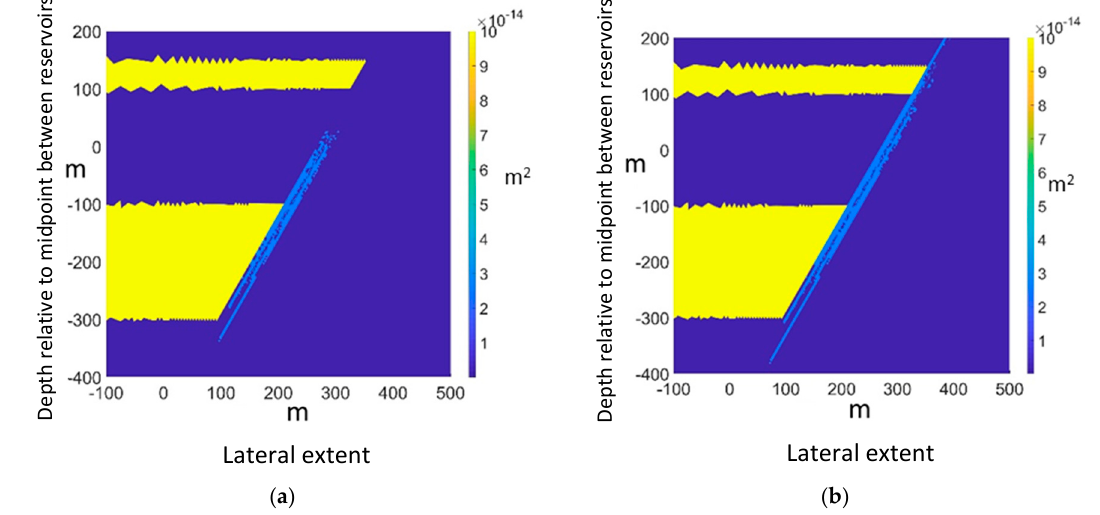
Figure 8. Permeability (in mD) distribution in the simulation domain. Intact element permeability is assigned by the user (yellow: sandstone; dark blue: shale, light blue: computed permeability in failed process zone elements). ( a ) 5 MPa depletion; ( b ) 10 MPa depletion (reservoirs in the hanging wall).